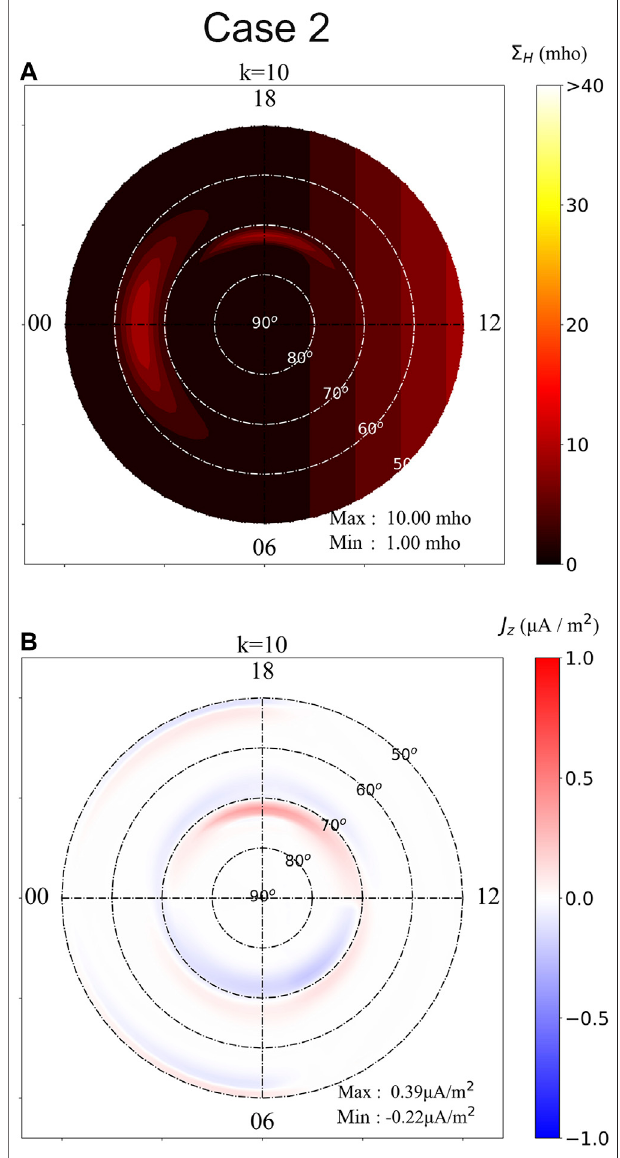
FIGURE 3 | Color-level plots of (A) Σ H and (B) J z obtained from the 10th step of the simulation study of Case 2. Case 2 simulation has a time- (cid:1) 54 ° .TheHalleffectinthethinplasma independent R m distributionwith λ R m (cid:1) 0 sheetisturnedoffinCase2.Aweakupward fi eld-aligned currentcanbe found at the duskside of the polar cap boundary, which can slightly enhance the conductance in that